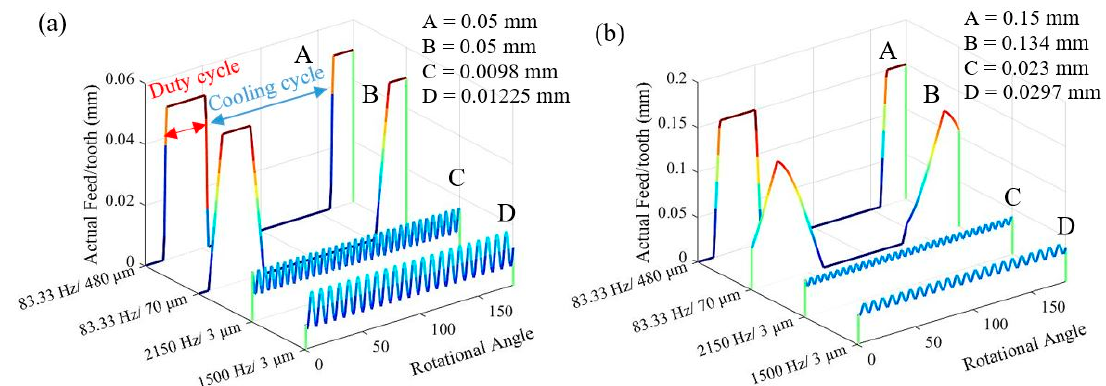
Figure 2. Effect of vibration-assisted drilling (VAD) frequency and amplitude on the uncut chip thickness at ( a ) feed ( f ) = 0.025 mm/rev and ( b ) f = 0.075 mm/rev.